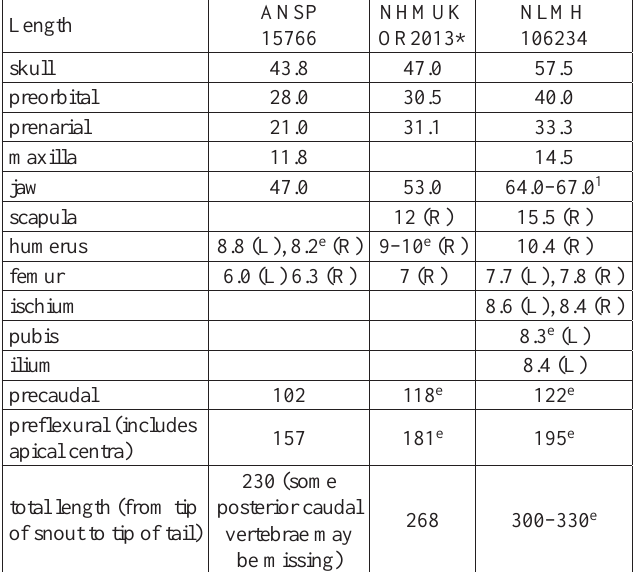
Table 1. Measurements (in cm) of Ichthyosaurus somersetensis speci- mens, including the holotype (ANSP 15766) and a referred specimen, compared with NLMH 106234. (L/R), left/right skeletal elements; e , estimated measurement because the bone was damaged, rotated or partially buried; 1 , see Materials and methods for details. The precaudal and preflexural lengths do not include the skull length. Note: NHMUK OR2013* is behind glass and not accessible for measurement, so a cast was measured instead. Some of the measurements are estimates because the cast does not display good enough